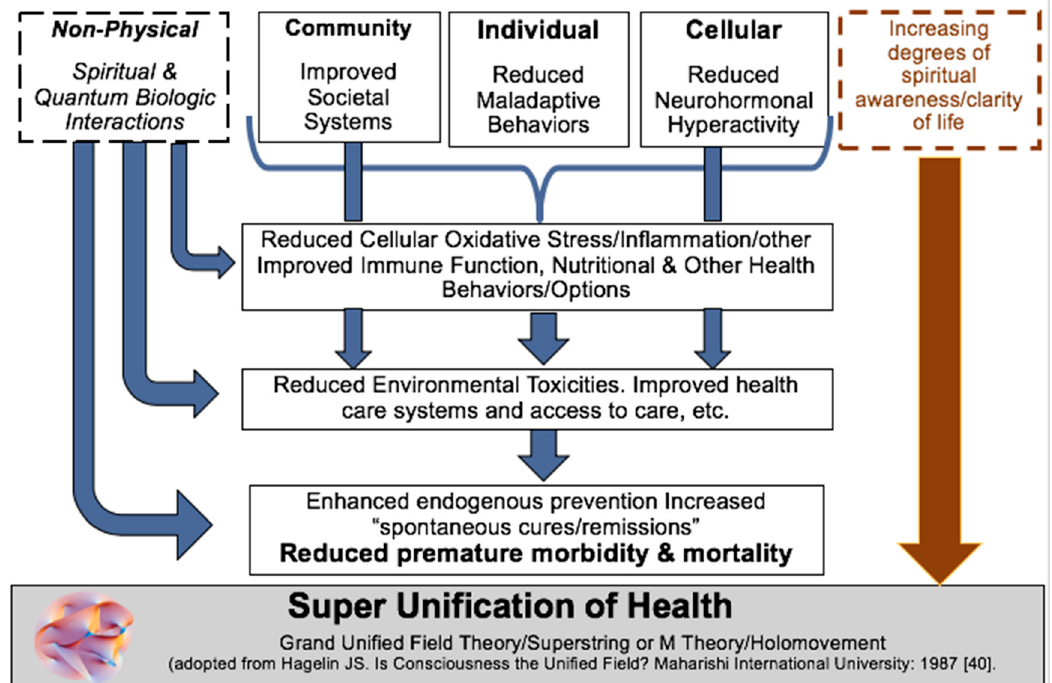
Figure 2. Legend: Four proposed major domains of health: ( 1 ) spiritual and quantum interactions; ( 2 ) community; ( 3 ) individual; and ( 4 ) cellular all interact through multiple pathways to reach a space where all four operate in synchrony, analogous to super ‐ unification of the major forces of nature within physics [41]. Superimposed with this is the vision that contemplative practices may enhance spiritual awareness or a sense of oneness to advance us along the path toward a space where there may emerge a state of super unification of health.